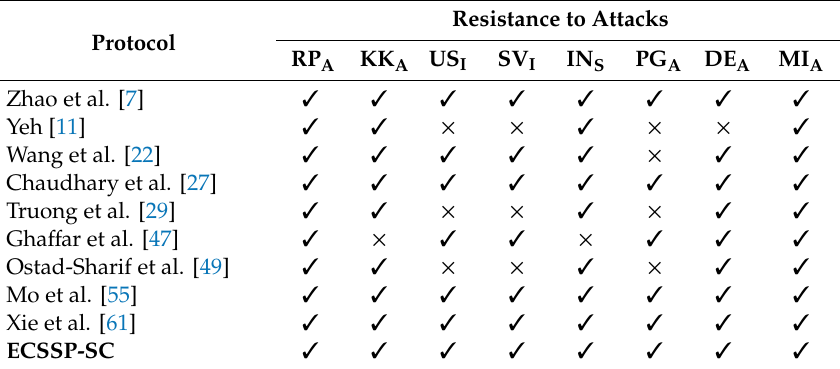
Table 6. Resistance capability of di ff erent smart card security protocols against